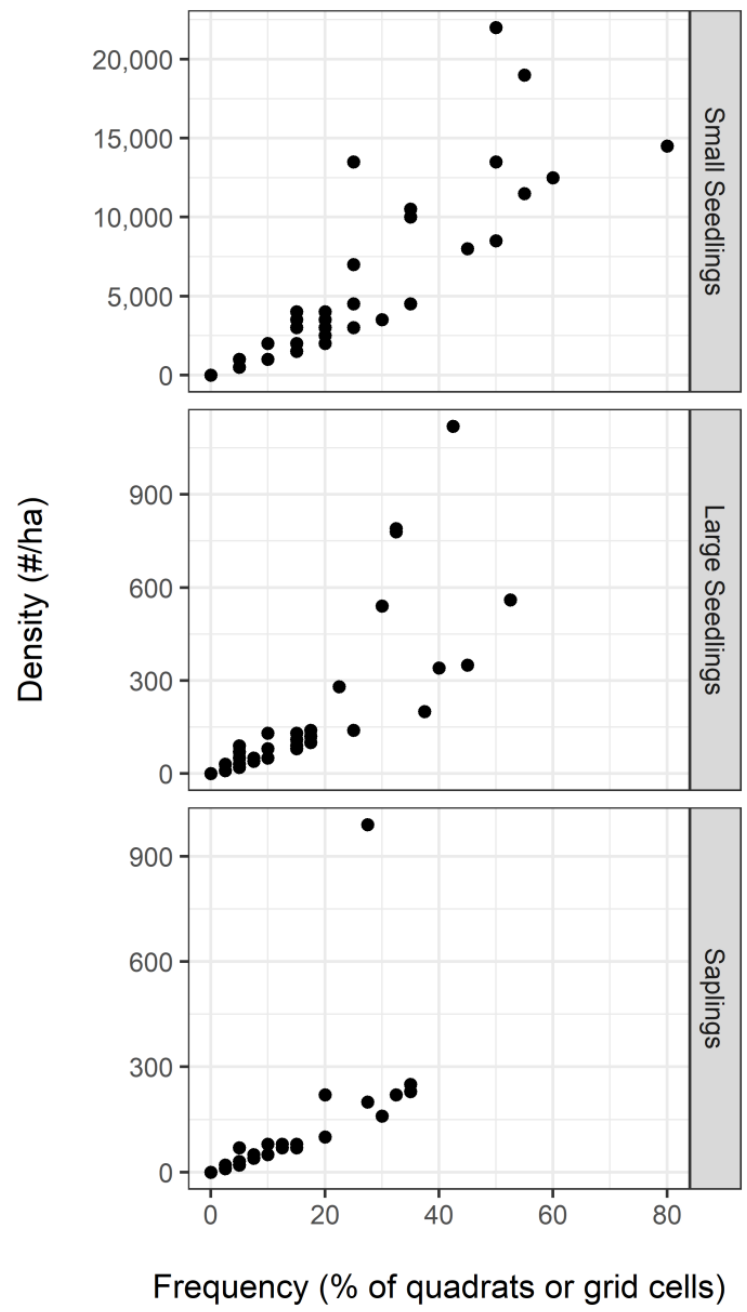
Figure 8. Density versus frequency of small seedlings, large seedlings, and saplings in the Late sample (2015). Note the differences in scale of the vertical axes.